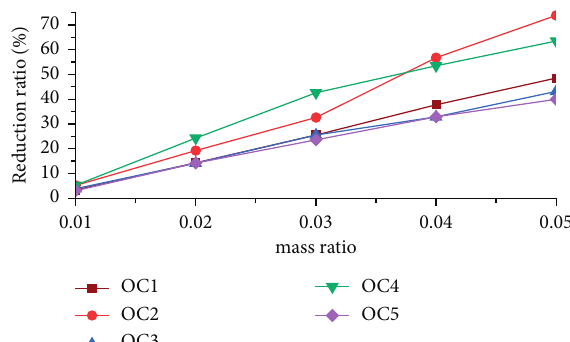
Figure 13: : Displacement reduction ratio of PTMDs of mass ratio from 1% to 5%.